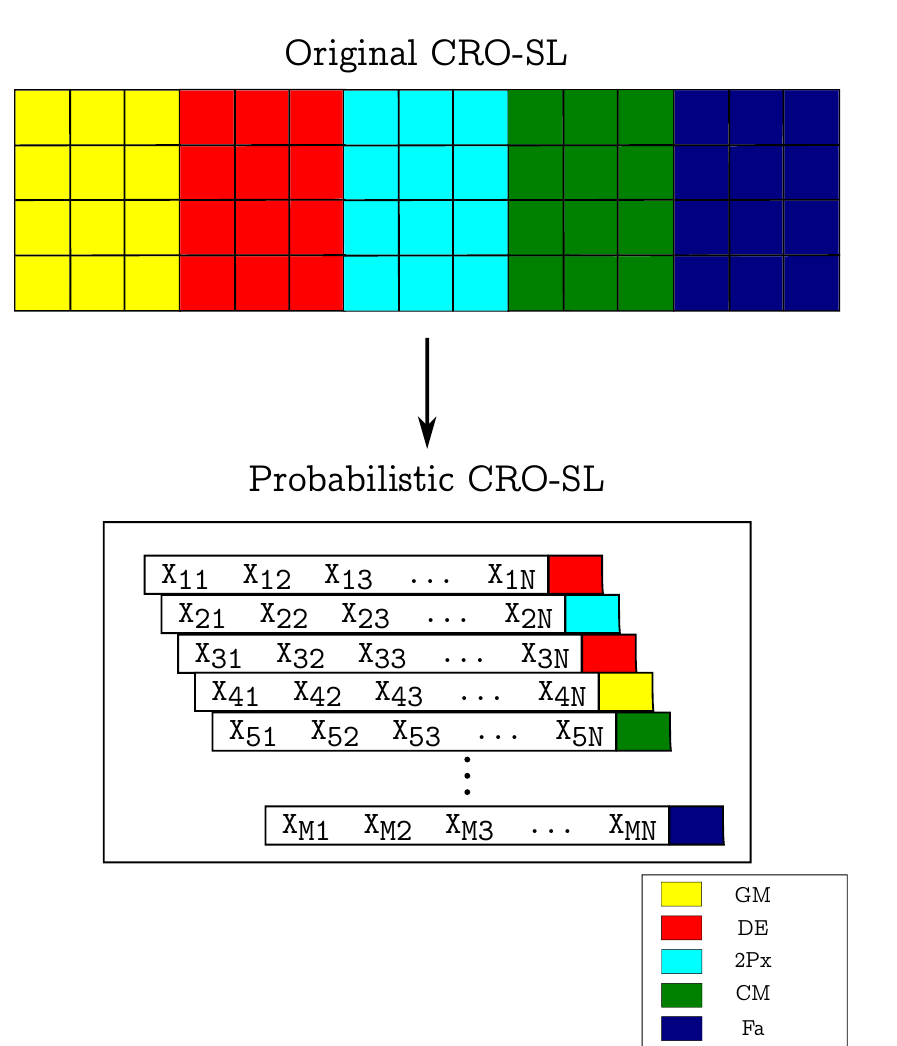
Figure 2. PCRO-SL (proposed) and CRO-SL